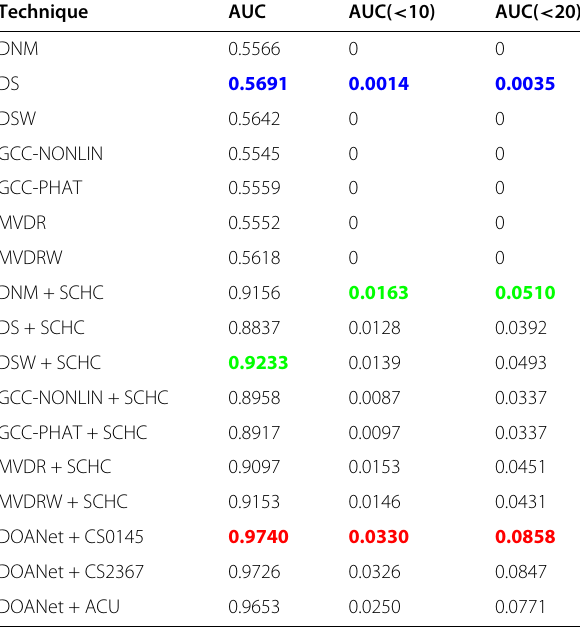
Table 8 AUC of in-flight elevation angle deviation